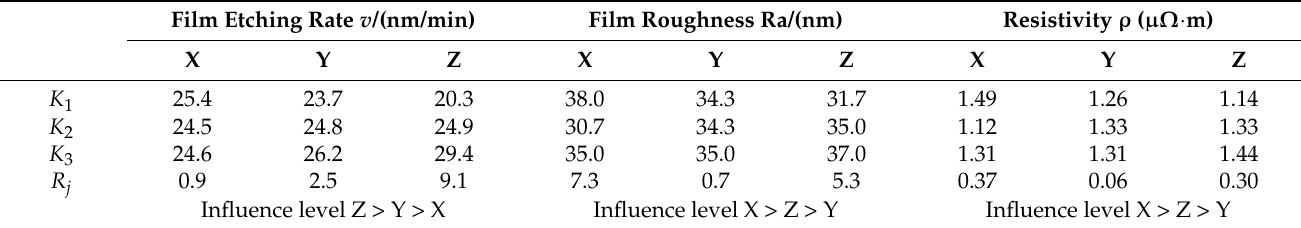
Table 9. Range analysis of thin-film etching experiment results.